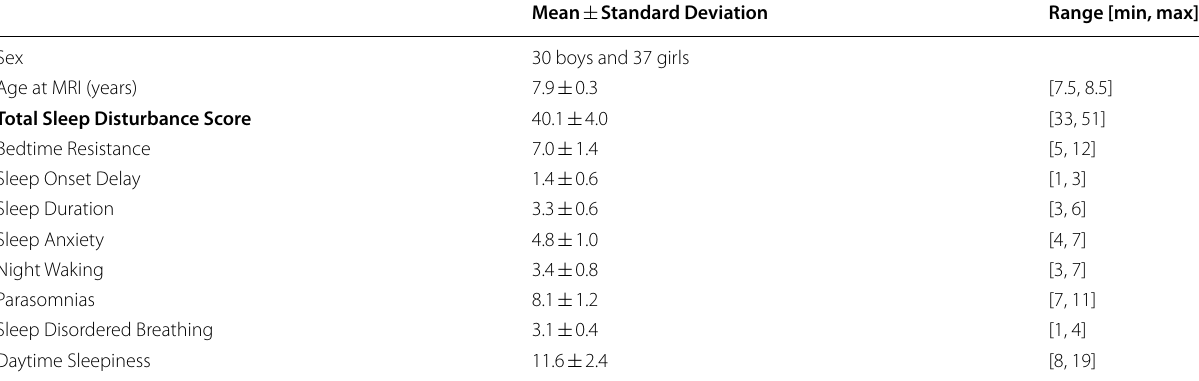
Table 1 Demographic information of the participants and their CSHQ sleep disturbance